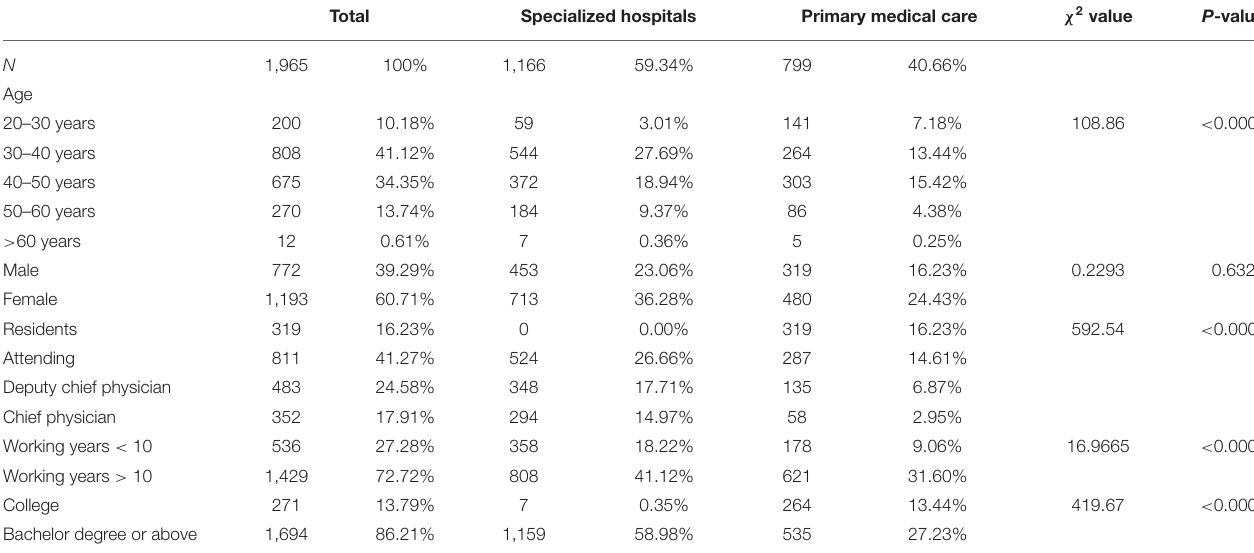
TABLE 2 | The demographic characteristics of the survey. Total Specialized hospitals